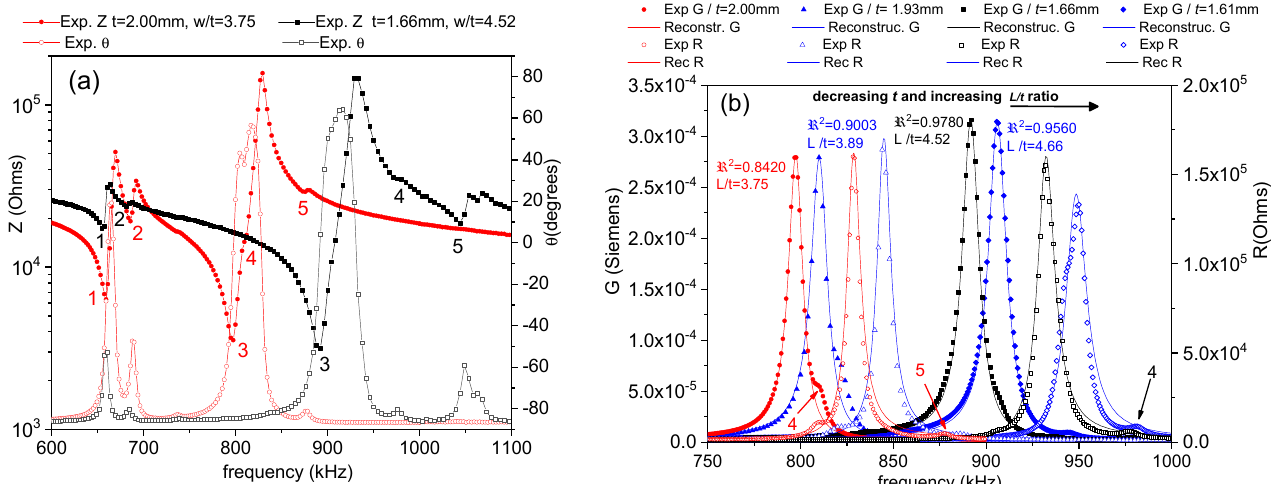
Figure 1. Shear resonance mode of non-standard, thickness ( t ) poled, and longitudinally ( L ) excited plates: ( a ) Impedance spectra in ( Z , θ ) plots, and ( b ) the same spectra in the equivalent ( R , G ) plots. In the ( Z , θ ) plots, the lines are only a “guide for the eye” in between the experimental points, and the frequency interval covers the lateral modes (marked as 1, 2, 4, and 5) at both sides of the fundamental shear mode (marked as 3). In the ( R , G ) plots, the symbols are the experimental data, and the lines are the reconstructed peaks after the calculation of the coefficients for the fundamental shear mode of the plates. The values of the regression factors for these calculations ( ℜ 2 ) are shown. Figure ( a ) shows two spectra: the one corresponding to the initial plate with t = 2 mm (red circles; full symbols for Z values and open symbols for θ values) and the one for the reduced plate with t = 1.66 mm (black squares; full symbols for Z values and open symbols for θ values). The other two dimensions, L = 7.49 mm and w = 7.45 mm, remain unaltered in the process. Figure ( b ) shows the two equivalent spectra for the same plates as in Figure ( a ), (red circles for t = 2 mm and black squares for t = 1.66 mm). In Figure ( b ) the full symbols are used for the G values, and open symbols are used for the R values. Additionally, in Figure ( b ) the spectra of an intermediate plate with t = 1.93 mm and L / t = 3.89 (blue triangles) and of a plate after a further thickness reduction to t = 1.61 mm and L / t = 4.66 (blue rhombus) are shown to complete the description of the resonance decoupling